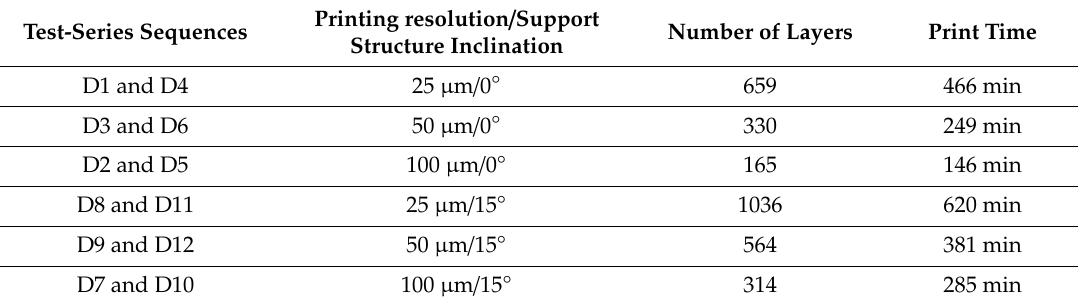
Table 3. Printer-calculated material-specific parameters and the sequence of tests